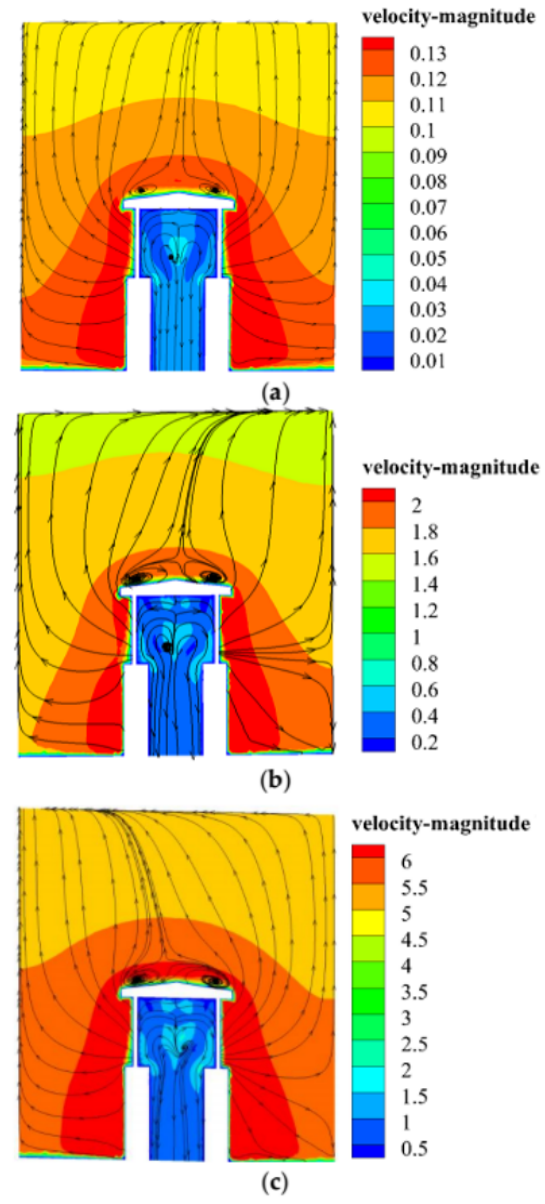
Figure 13. Distribution of velocity and streamlines evolution in yz-plane for different inlet wind velocities: ( a ) 0.1 m/s; ( b ) 1.5 m/s; and ( c ) 4